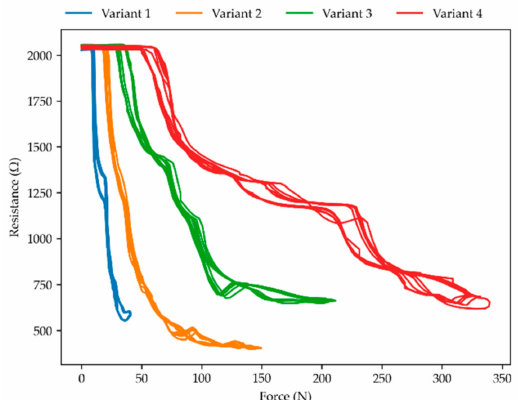
Figure 8. Resistance response upon force application for measurements with a gap of 0.5 mm at 10